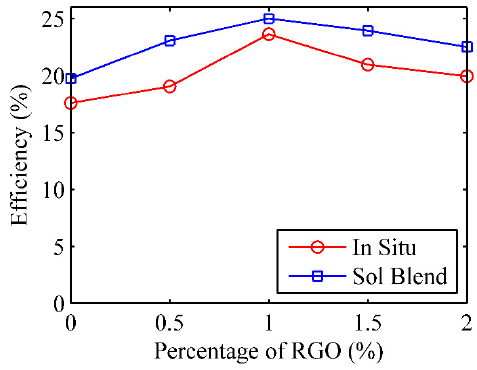
Figure 18. Solar energy conversion efficiency of the neat PMMA and its nanocomposites.